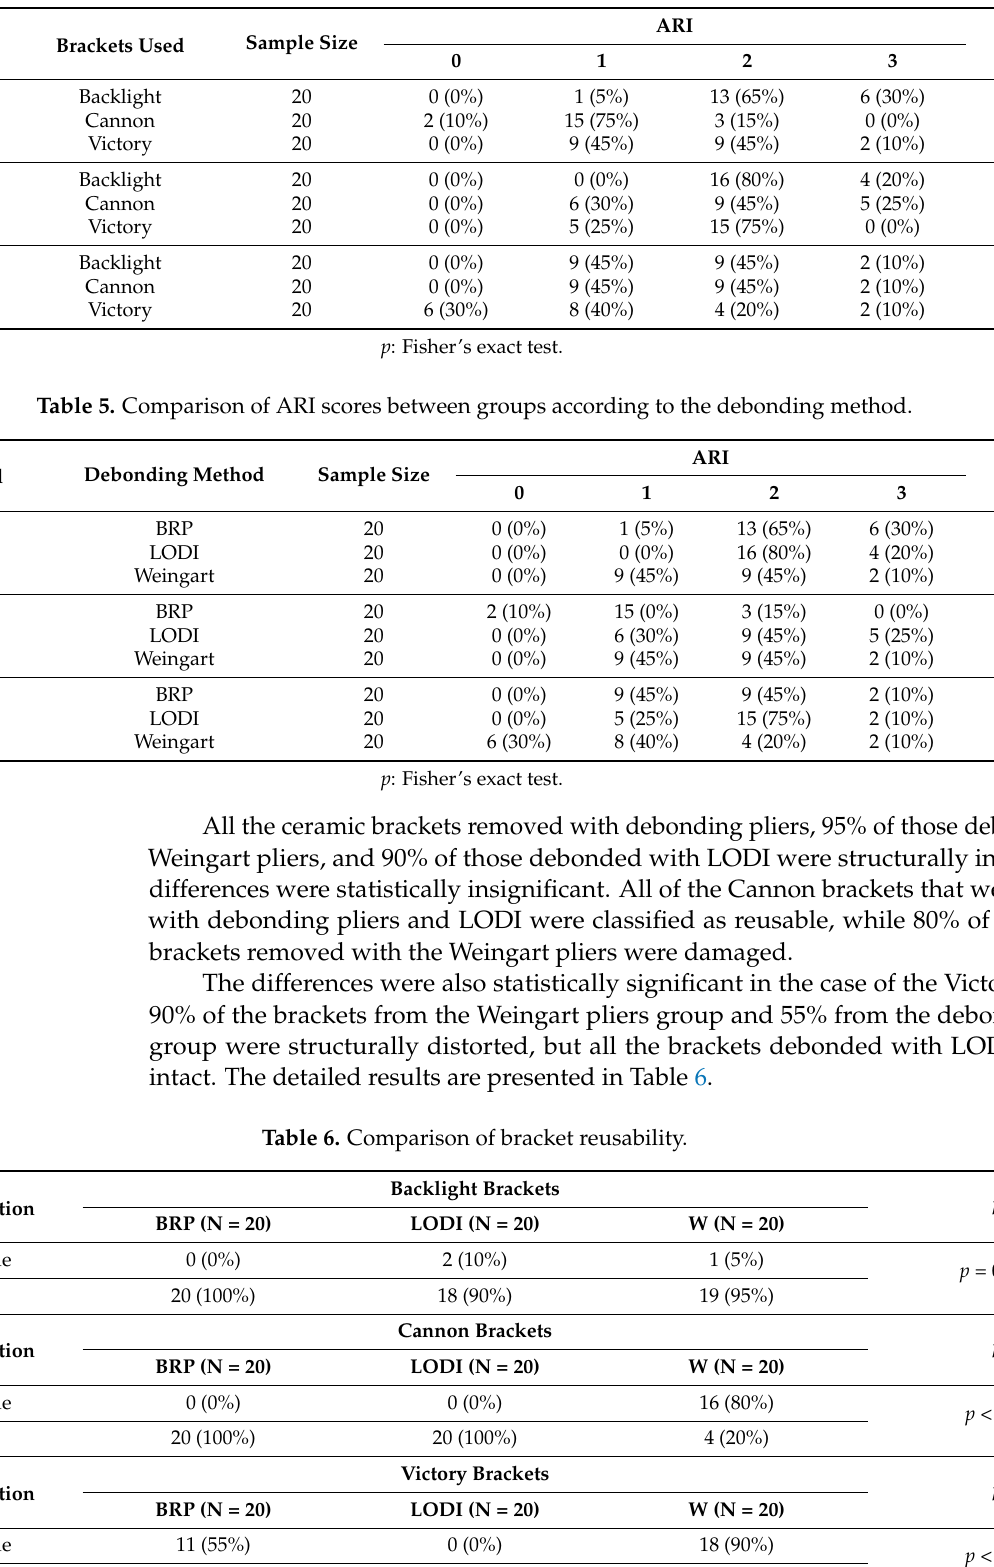
Table 4. Comparison of ARI scores between groups according to the type of bracket used.